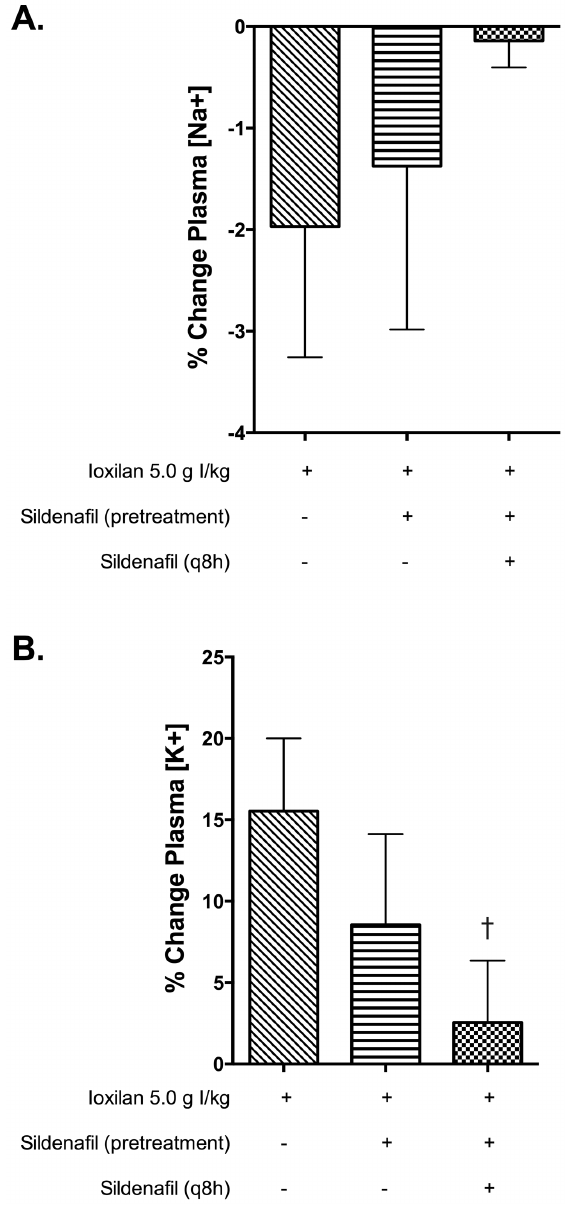
Figure 3. Repeated treatment with sildenafil citrate prevents hyponatremia and hyperkalemia in animals exposed to CM. (A) Percent change (t 5 0 vs. 48 h) in plasma Na + concentrations in animals administered intravenous ioxilan (5.0 g I/kg) with/without simultaneous sildenafil therapy. (B) Percent change (t 5 0 vs. 48 h) in plasma K + concentrations in animals administered intravenous ioxilan (5.0 g I/kg) with/ without simultaneous sildenafil therapy. Values are presented as mean ¡ SEM; n 5 3–5. { indicates p , 0.05 versus 5.0 g I/kg by one-way ANOVA and Dunnett’s multiple comparisons